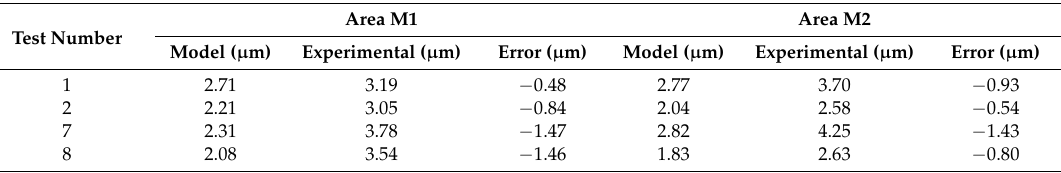
Table 8. SDAS validation of the